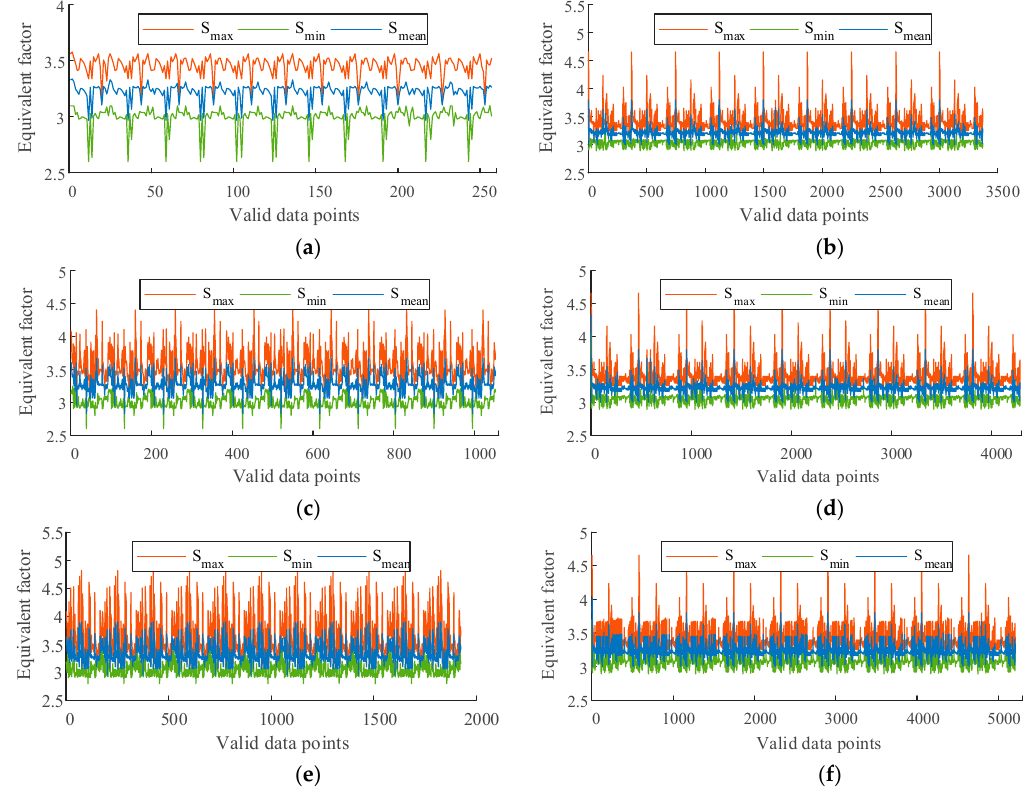
Figure 6. Optimal equivalent factor sequence, ( a ) 11-SC03, Initial SOC = 0.9; ( b ) 9-HWFET, Initial SOC = 0.9; ( c ) 11-SC03, Initial SOC = 0.6; ( d ) 9-HWFET, Initial SOC = 0.6; ( e ) 11-SC03, Initial SOC = 0.3; ( f ) 9-HWFET, Initial SOC = 0.3.